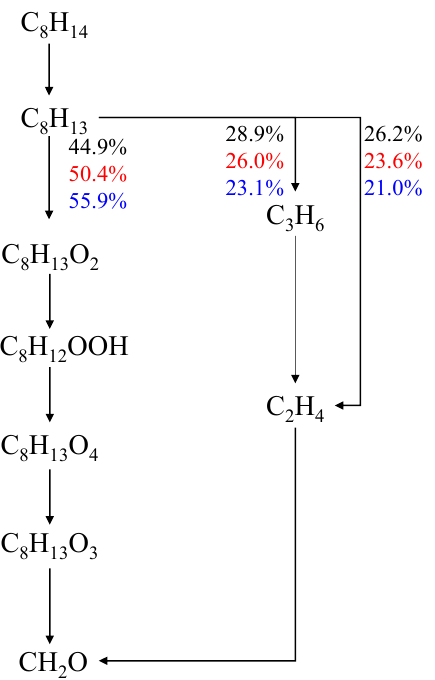
Figure 11. Sensitivity analysis of gasoline under different initial pressures.